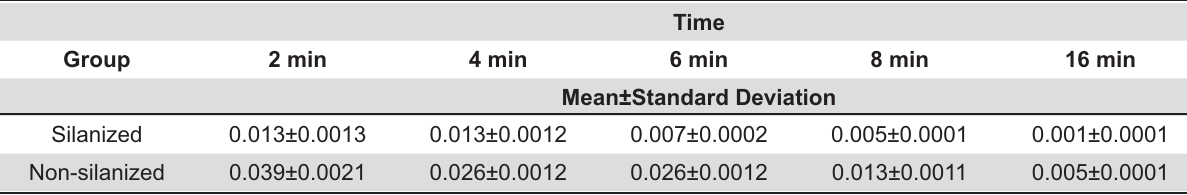
&(cid:6)(cid:10)(cid:26)(cid:24)(cid:8)(cid:12)(cid:29)(cid:24)(cid:16)(cid:29)(cid:24)(cid:8)(cid:24)(cid:14)(cid:5)(cid:12)(cid:5)(cid:23)(cid:24)(cid:12)%(cid:24)(cid:6)(cid:14)(cid:12)(cid:28)(cid:27)(cid:12)’(cid:12)(cid:8)(cid:6)%(cid:16)(cid:10)(cid:24)(cid:8)/(cid:12)(cid:31)(cid:6)(cid:5)(cid:6)(cid:12)(cid:6)(cid:29)(cid:24)(cid:12)(cid:24);(cid:16)(cid:29)(cid:24)(cid:8)(cid:8)(cid:24)(cid:31)(cid:12)(cid:7)(cid:14)(cid:12)<=>%(cid:7)(cid:14) -1 .